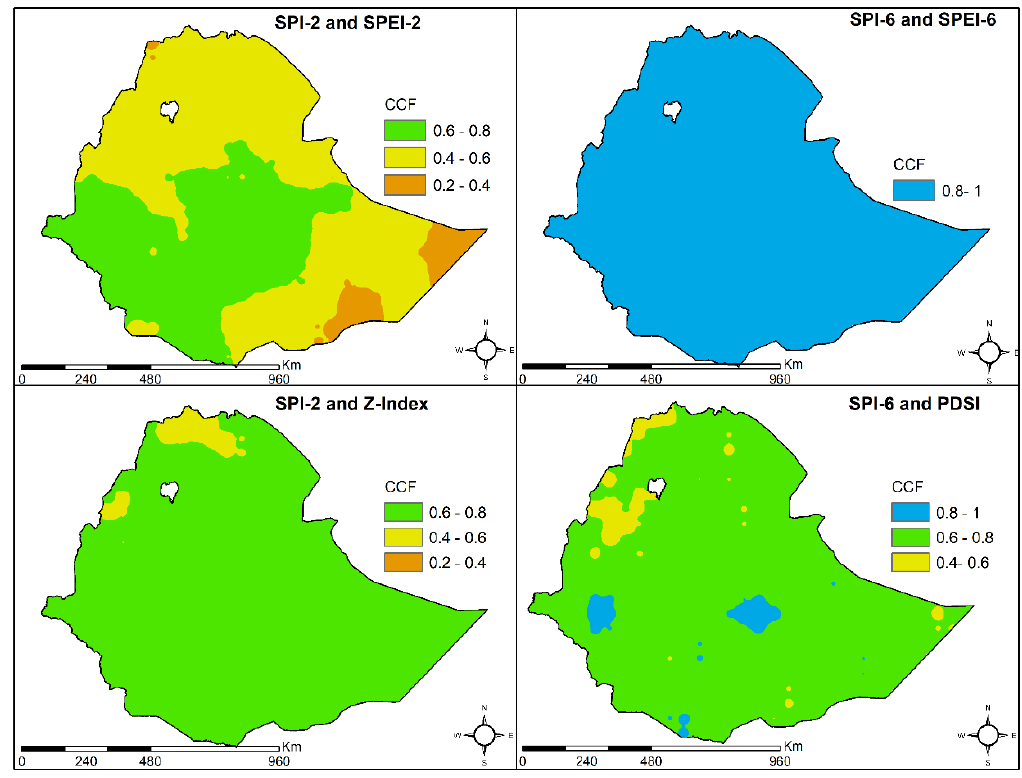
Figure 2. Maximum Cross-Correlation Coefficient between meteorological (SPI) and agricultural (SPEI, Z-index, PDSI) droughts in Ethiopia.